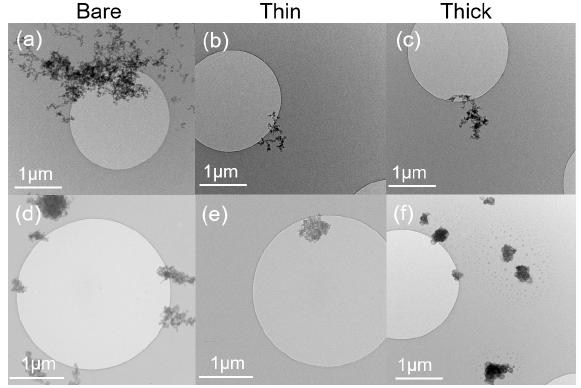
Figure C2. TEM images for 200nm size-selected bare and coated mCASTblack and FW200 soot particles with a lower magnifica- tion as shown in each image. Scale bars are indicated in each im- age. (a) Bare mCASTblack, (b) mCASTblack with a thin coating (coating wt = 2.9%), (c) mCASTblack with a thick coating (coat- ing wt = 30.2%), (d) bare FW200, (e) FW200 with a thin coat- ing (coating wt = 2.3%), and (f) FW200 with a thin coating (coat- ing wt = 139.3%). Microscopes used: (a) – (c) and (f) TFS F30, (d) and (e) Hitachi